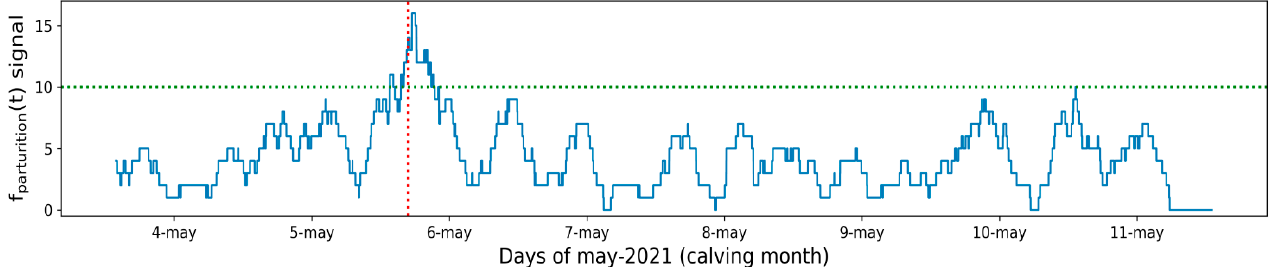
Figure 8. Number of lying bouts (function f parturition ( t ) ), in the last five hours calculated with a rolling window for cow 03 for a week. Dotted red line signalizes the corresponding calving instant. Dotted green line denotes a candidate value to detect the parturition event.